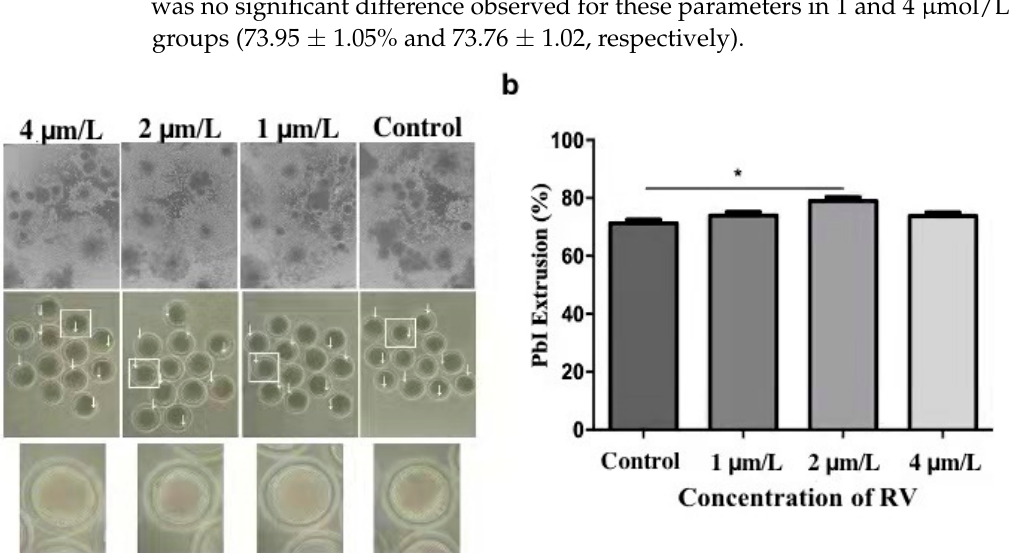
Figure 1. RV treatment reverses aging-induced impairment in aged porcine oocytes. ( a ) The representative images showing degrees of cumulus spread and first polar body extrusion rate, as indicated by white arrows. ( b ) The graph showing PB1 extrusion percentage rate at various concentrations (0, 1, 2, and 4 μ mol/L RV). Significant difference (* p < 0.05).